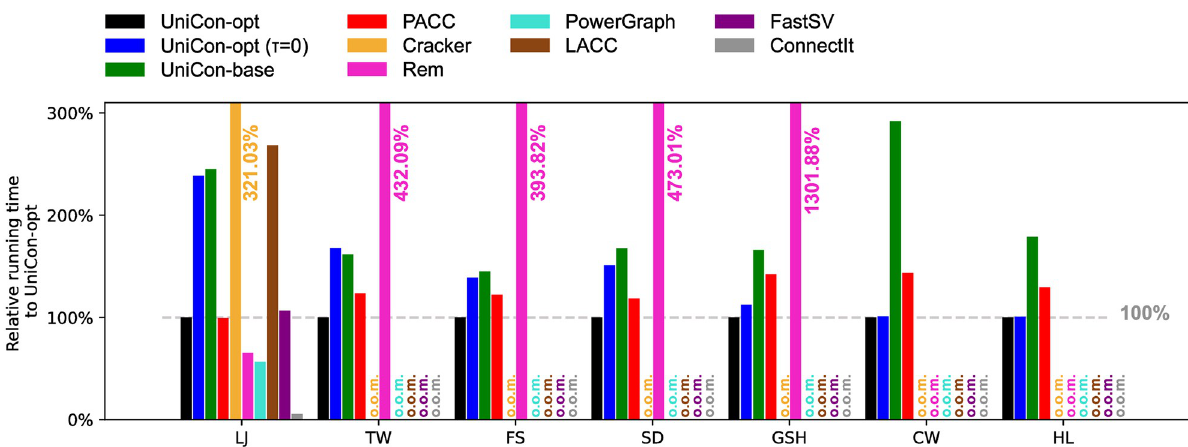
Fig 15. The relative running time, compared to UniCon-opt, of competitors on real-world graphs. o.o.m.: out-of-memory error. UniCon-opt with optimal τ outperforms all competitors on all graphs except for LJ. Rem, ConnectIt, and PowerGraph are faster than UniCon-opt on LJ but fail on all other graphs because of out-of-memory errors.